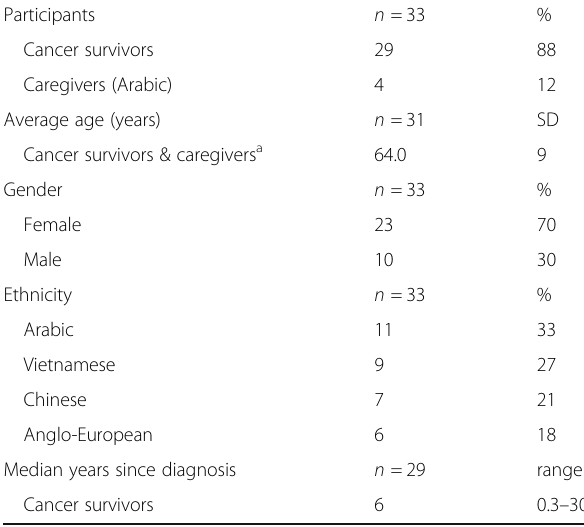
Table 1 Characteristics of focus group participants